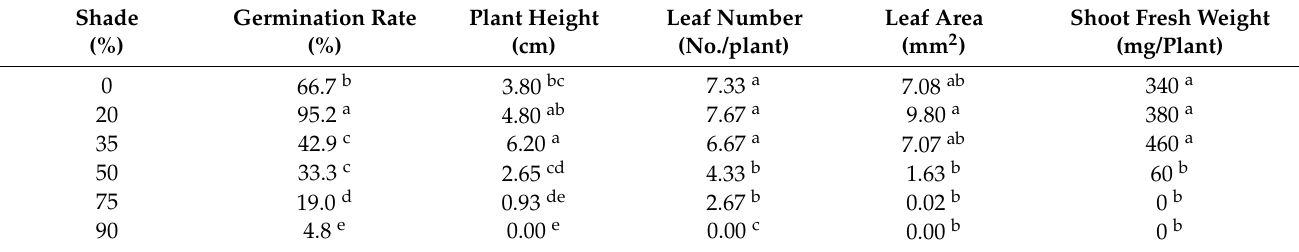
Table 3. Germination rate and growth of A. patulus 10 days after seeding, grown from seeds planted at different shading degrees in field